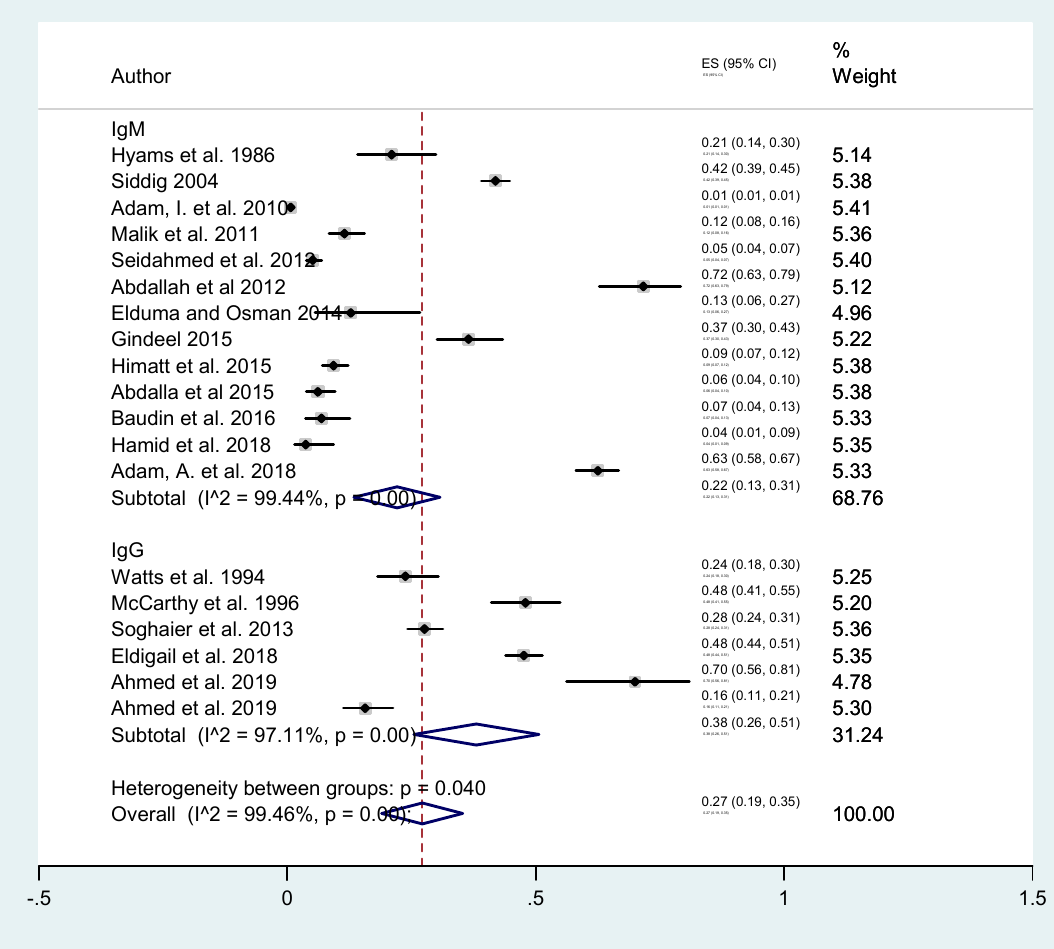
Heterogeneity between groups: p = 0.040 Overall (I^2 = 99.46%, p = 0.00);